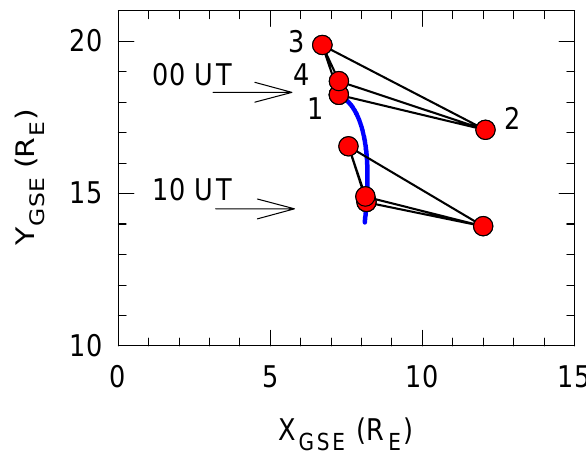
Fig. 9. Representation of the Cluster constellation in the X − Y plane in the GSE coordinate system on 25 December 2000. The spacecraft constellation is shown magnified by a factor of